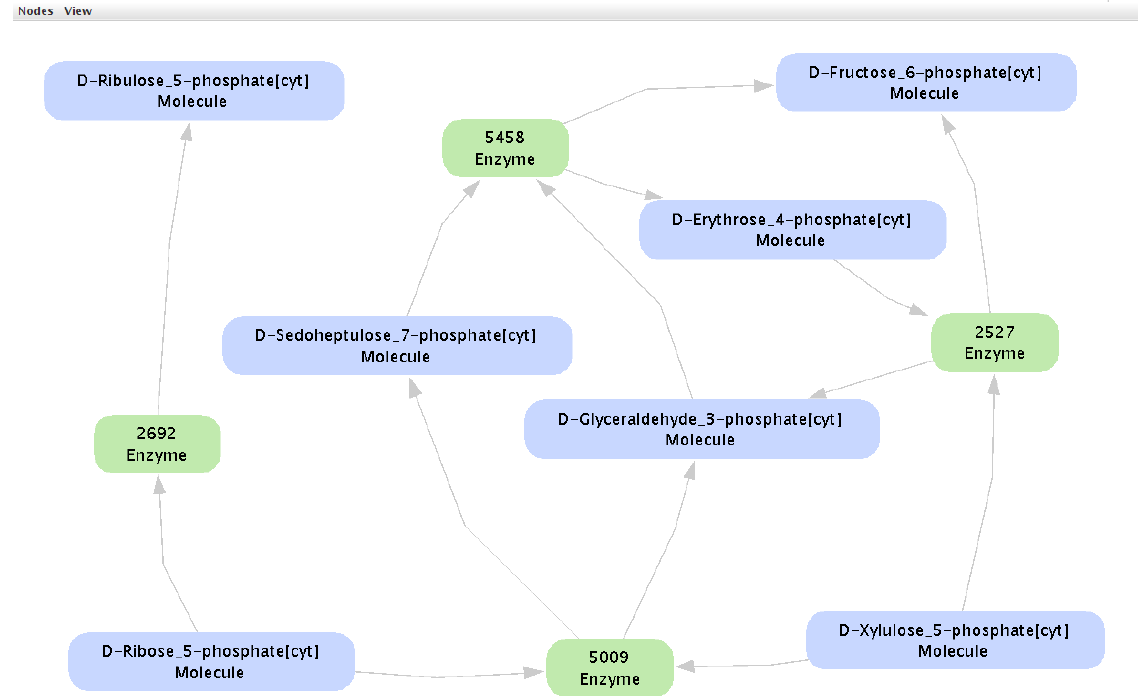
Figure 5: Visualisation of a small example model with four enzymatic reactions (green nodes) and seven metabolites (blue nodes) in the BMVis